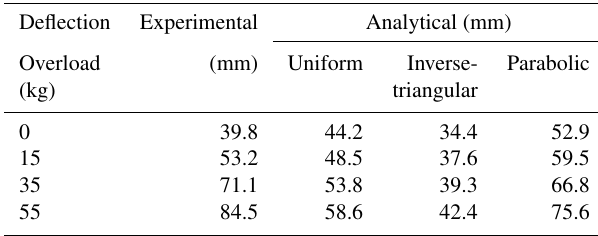
Figure 10. Initial and final (after opening cavity) vertical stresses for cohesive